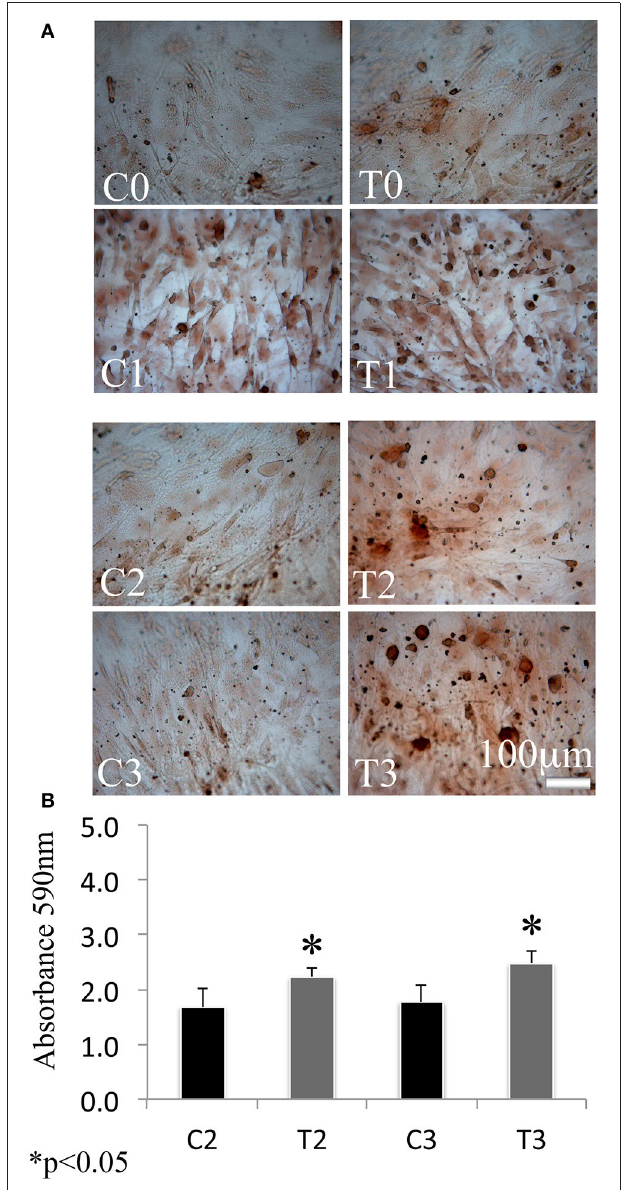
FIGURE 3 | Time-course effects of laser irradiation on calcium deposition. BMSCs grown in osteogenic medium, as detailed in the Materials and Methods section, were laser irradiated over different period of time (Day 0: T0; 5 days: T1; 10 days: T2; 15 days: T3). Control cultures (Day 0: C0; 5 days: C1; 10 days: C2; 15 days: C3) were maintained in identical conditions except that the laser device was kept off. The results show the Alizarin red S staining observed with a light microscope (Bar, 100 µ m) (A) and are in accordance with quantitative analysis of Alizarin red staining in which the values are reported as means ± SD and statistically analyzed; * p < 0.05. vs. the corresponding untreated BMSCs (B) .